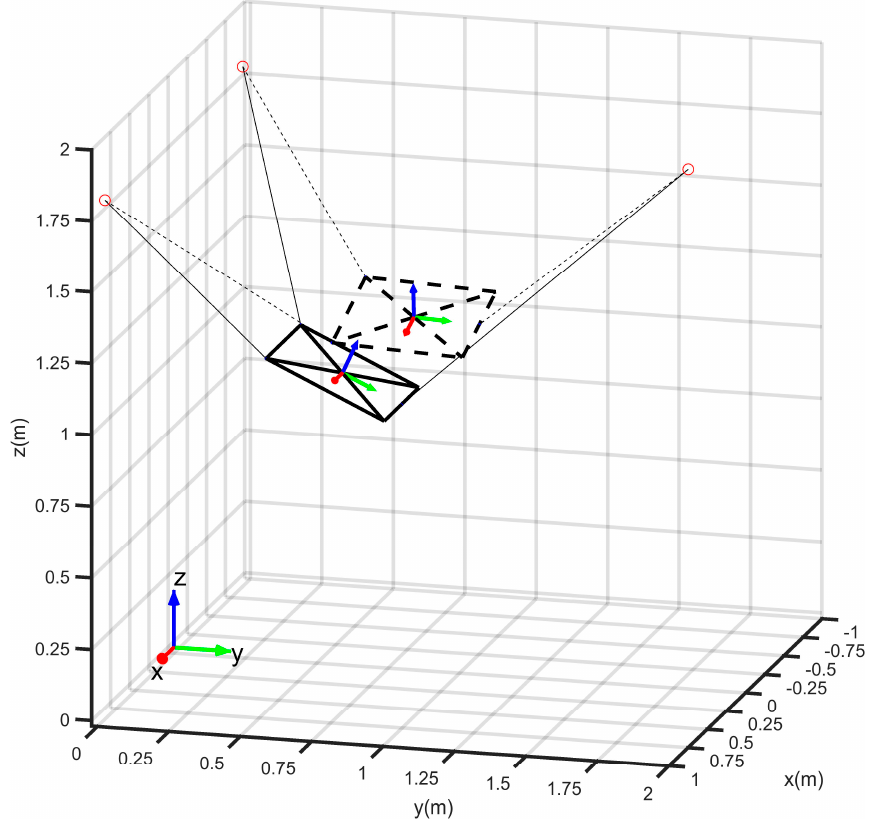
Figure 5. Initial state (solid line) and end state (dashed line) for unconstrained parallel robot trajectory planning.